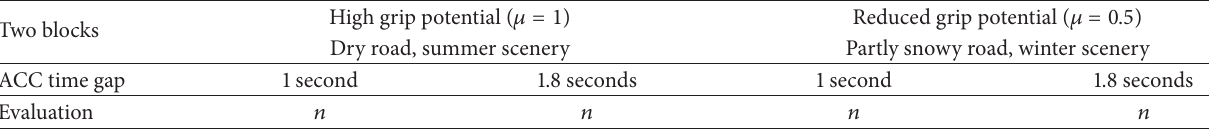
Table 1: Experimental